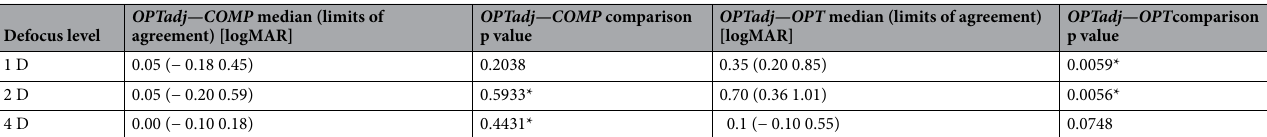
Table 2. VA (logMAR) comparisons between different methods of blur. A median closer to zero and narrower limits of agreement indicate better agreement between compared methods. The p value relates to the result of a paired Student t test or a Wilcoxon sign test